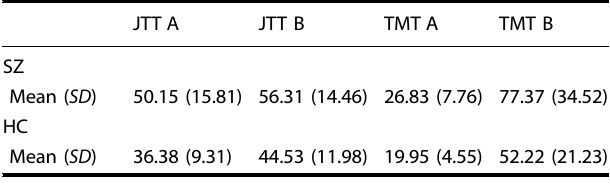
Cognitive performance represents time in seconds to complete the test. Cognitive performance was measured in seconds where a greater completion time represents a poorer score. TMT Trail Making Test, SD standard deviation, SZ schizophrenia, HC healthy controls.